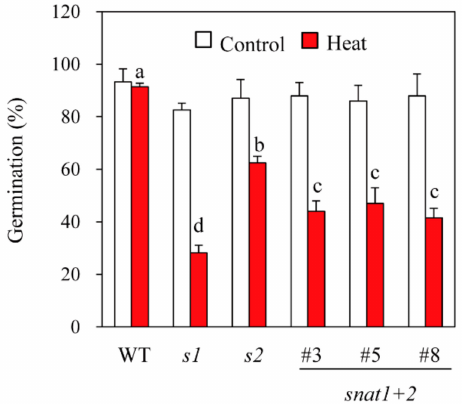
Figure 6. Seed germination in response to accelerated aging treatments. Rice seeds were exposed to heat (42 ◦ C) under high humidity for four days, followed by germination at 28 ◦ C for six